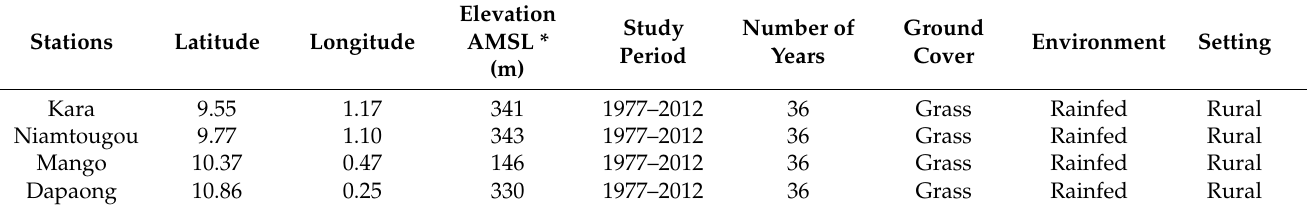
Table 1. Metadata for the selected meteorological stations used in the study.